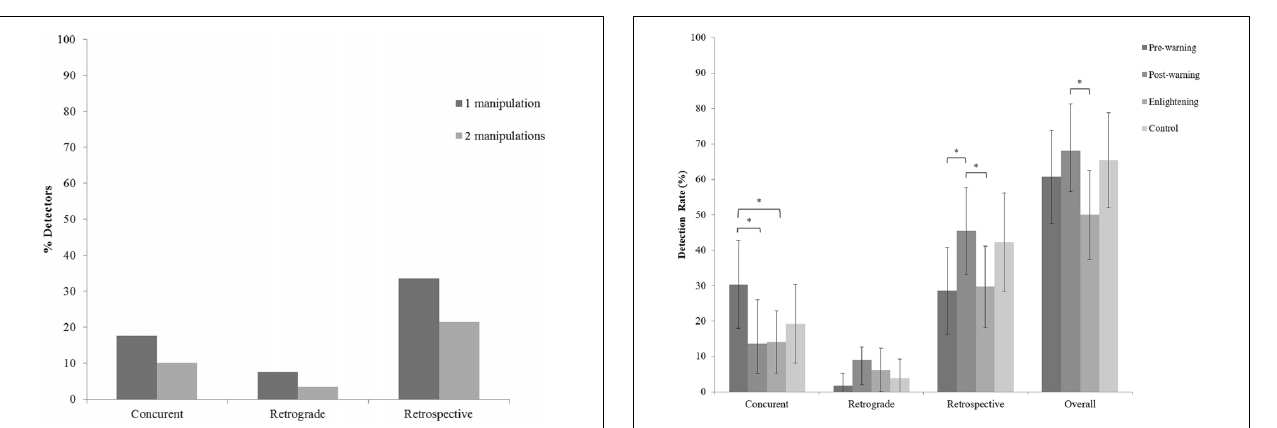
FIGURE 2 | Proportion of participants who detected one or two manipulations concurrently, retrogradely, and in retrospect. The data are aggregated across four warning conditions.